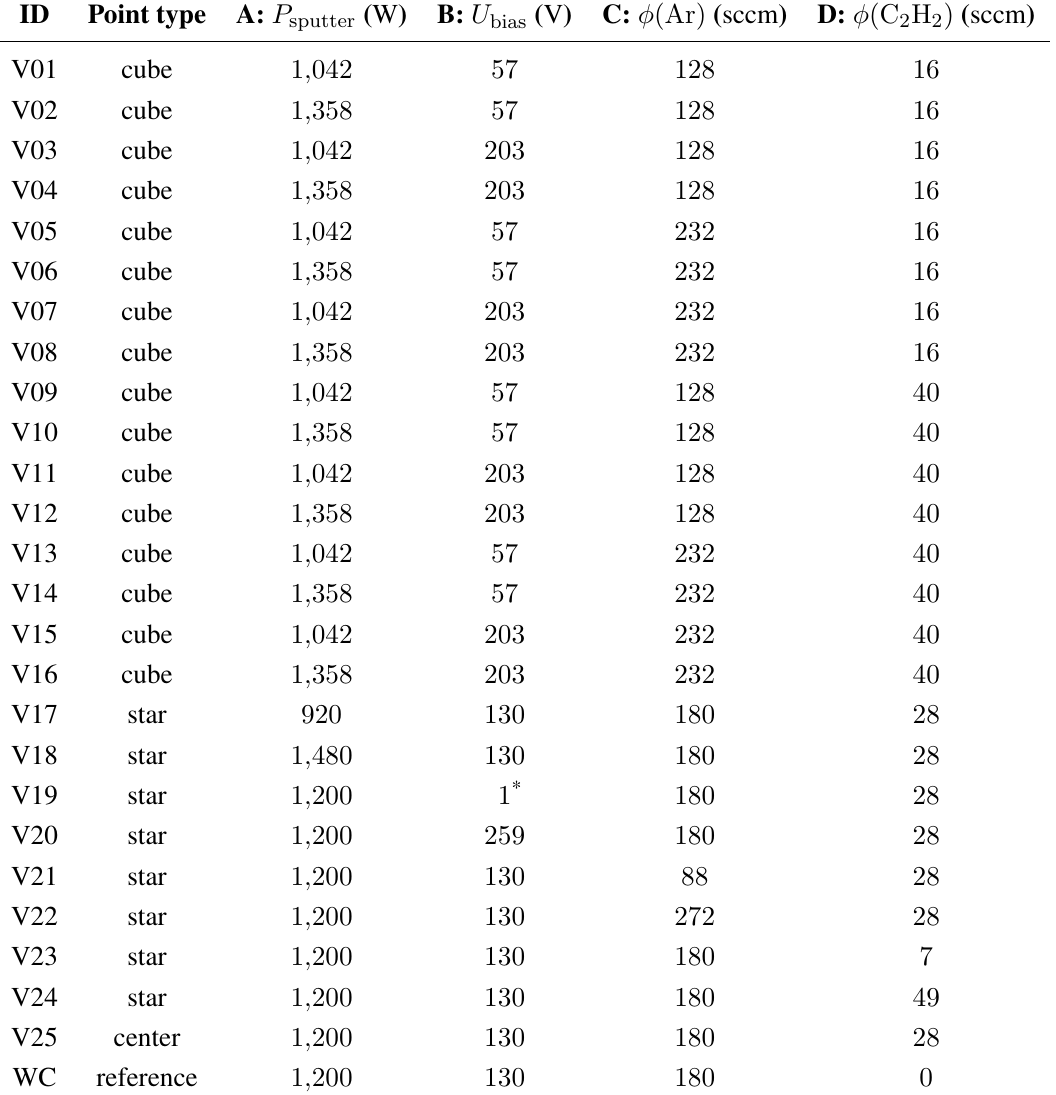
Table 1 . Set points of the deposition parameters (factors), which were systematically varied for the deposition of different a-C:H:W coatings according to the central composite design. Each of the individual parameters was varied in five factor